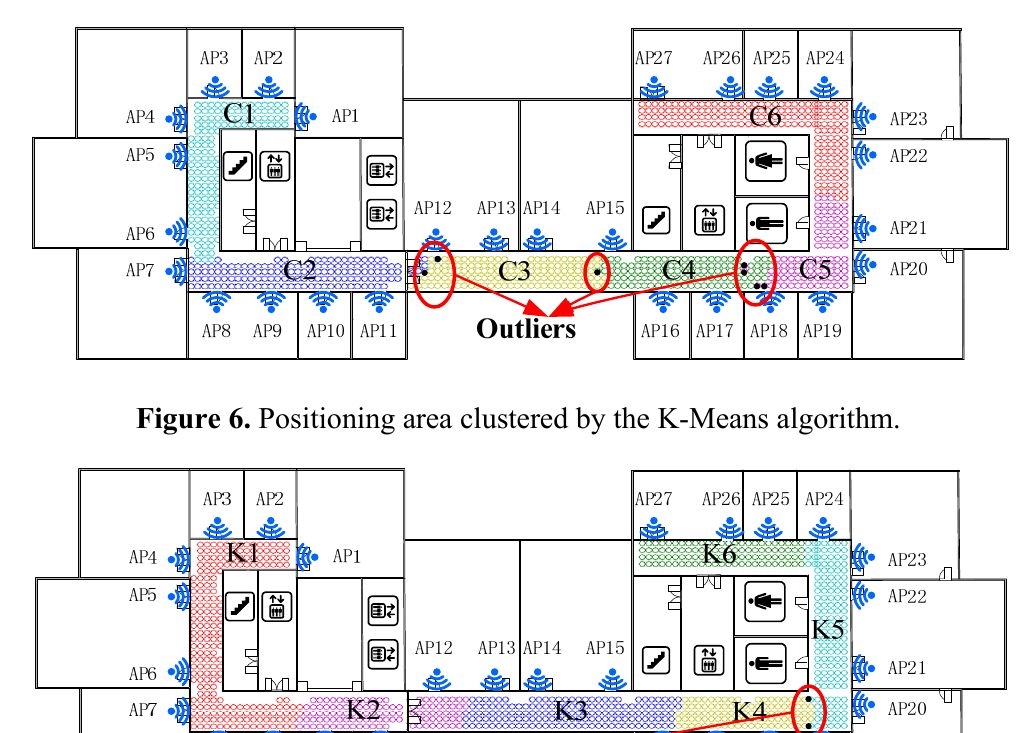
Figure 5. Positioning area clustered by the FCM algorithm.